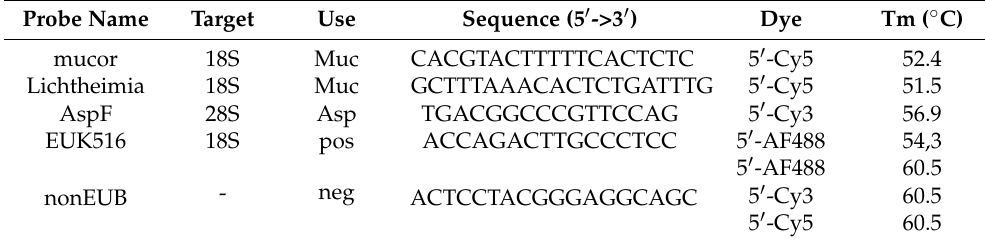
Table 1. List of used FISH probes: pos: positive control, neg: negative control, AspF: Aspergillus spp., EUK516: unspecific eukaryotic probe, nonEUB: nonsense probe, Muc: probe targeting